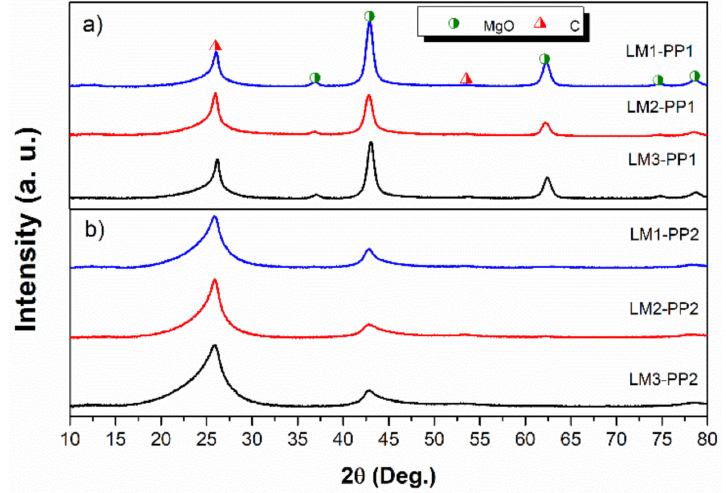
Figure 5. XRD patterns of ( a ) PP1 and ( b ) PP2 samples.